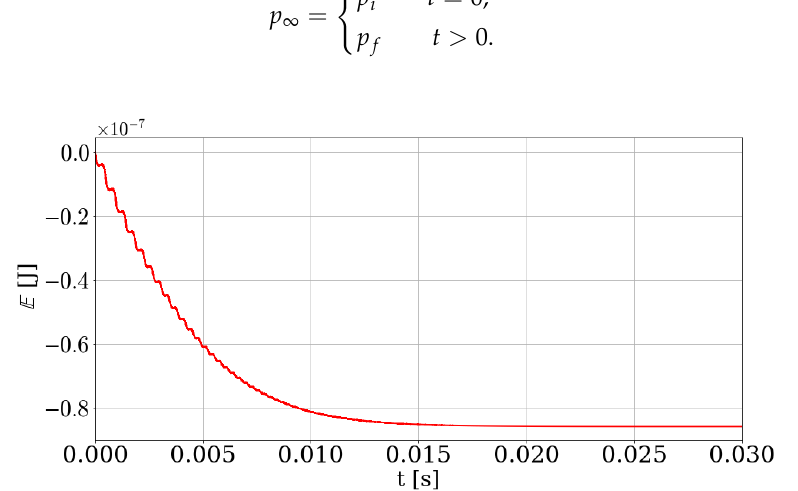
Figure 7. Variation of the Total Energy with time for a reference step pressure (Equation (24)) specified by p i = 0 bar and p f = − 0.69 bar gage pressure with the same fluid properties as that chosen for the case shown in Figure